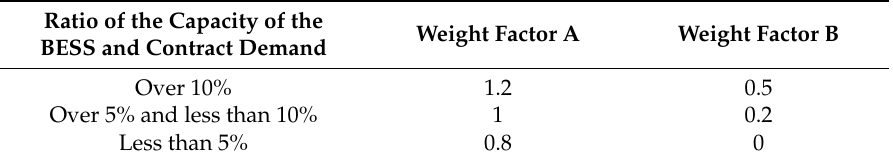
Table 3. Weight factors applied to the charge discount in Korea.